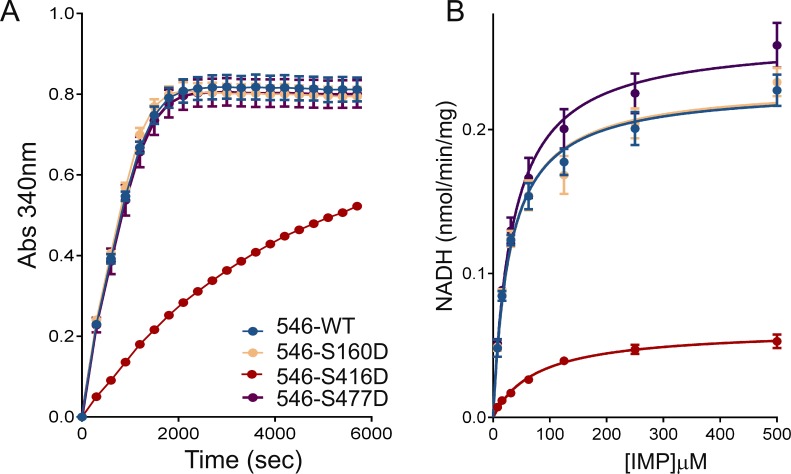
Effect of phosphomimetic substitutions on enzymatic activity.(A) Reaction kinetics of wildtype; S160D; S416D and S477D mutants of hIMPDH1α (546aa). Assays were performed with 3,6 μM of recombinant protein in assay buffer with 125 mM IMP and 0.5 mM NAD+. Results represent the mean and S.E.M of three independent experiments with three technical replicates each. S160D and S477D mutants showed wildtype kinetics; while S416D mutant showed delayed kinetics. (B) Michaelis-Menten plots for the wildtype and phosphomimetic mutants. NADH production plotted to concentration of IMP. Assays were performed at 0.5 mM NAD+ and varying concentrations of IMP, from 0 to 500 μM. NADH production (nmol/min/mg) was obtained from ΔAbs/Δt by applying Lambert- Beer’s law (εNADH340nm=6220M−1cm−1, l = 0.58 cm), and results were fitted to Michaelis-Menten curves with GraphPad Prism [Mean and S.E.M of three independent experiments, three technical replicas each].